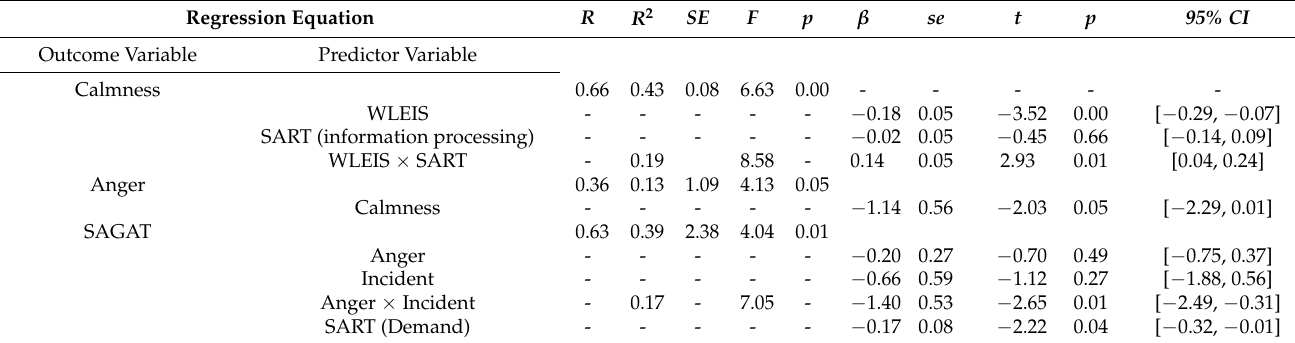
Table 3. Moderating effect index.